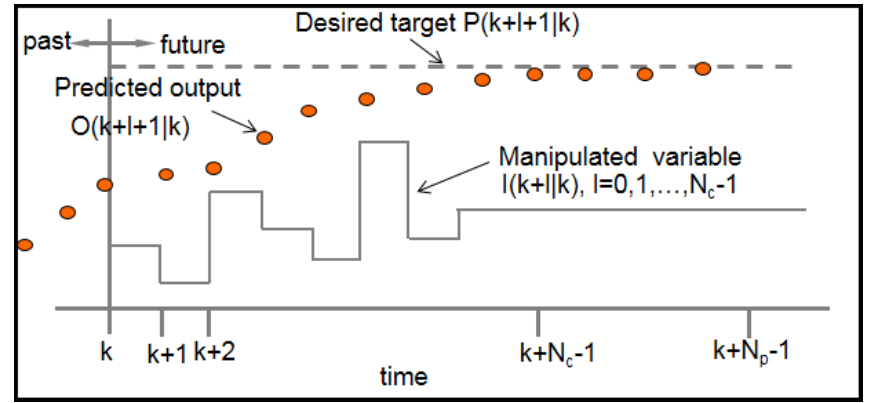
Figure 8. Prediction and controller move optimality in